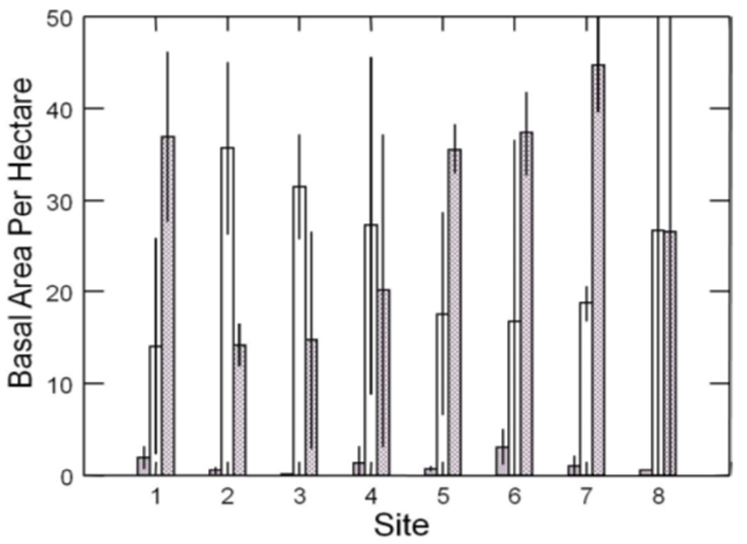
Figure 3. Basal area (m 2 ha − 1 + s.e.) for the three dominant tree species A. rubrum var. drummondii (gray), N. aquatica (open) and T. distichum (hatched) at Sites 1–8 in 2017. Stem density in 2017 averaged 1012 per hectare and ranged between 528 and 1568 (Figure 4) and was highest at the reference site. This is the same site as Conner and Day’s [5,7] “natural” site, which had stem densities ranging between 880 and 990 stems per hectare. Acer rubrum var. drummondii had the greatest number of stems only at Site 7, whereas Nyssa aquatica contained the greatest number of stems at five of the eight sites (Figure 5).